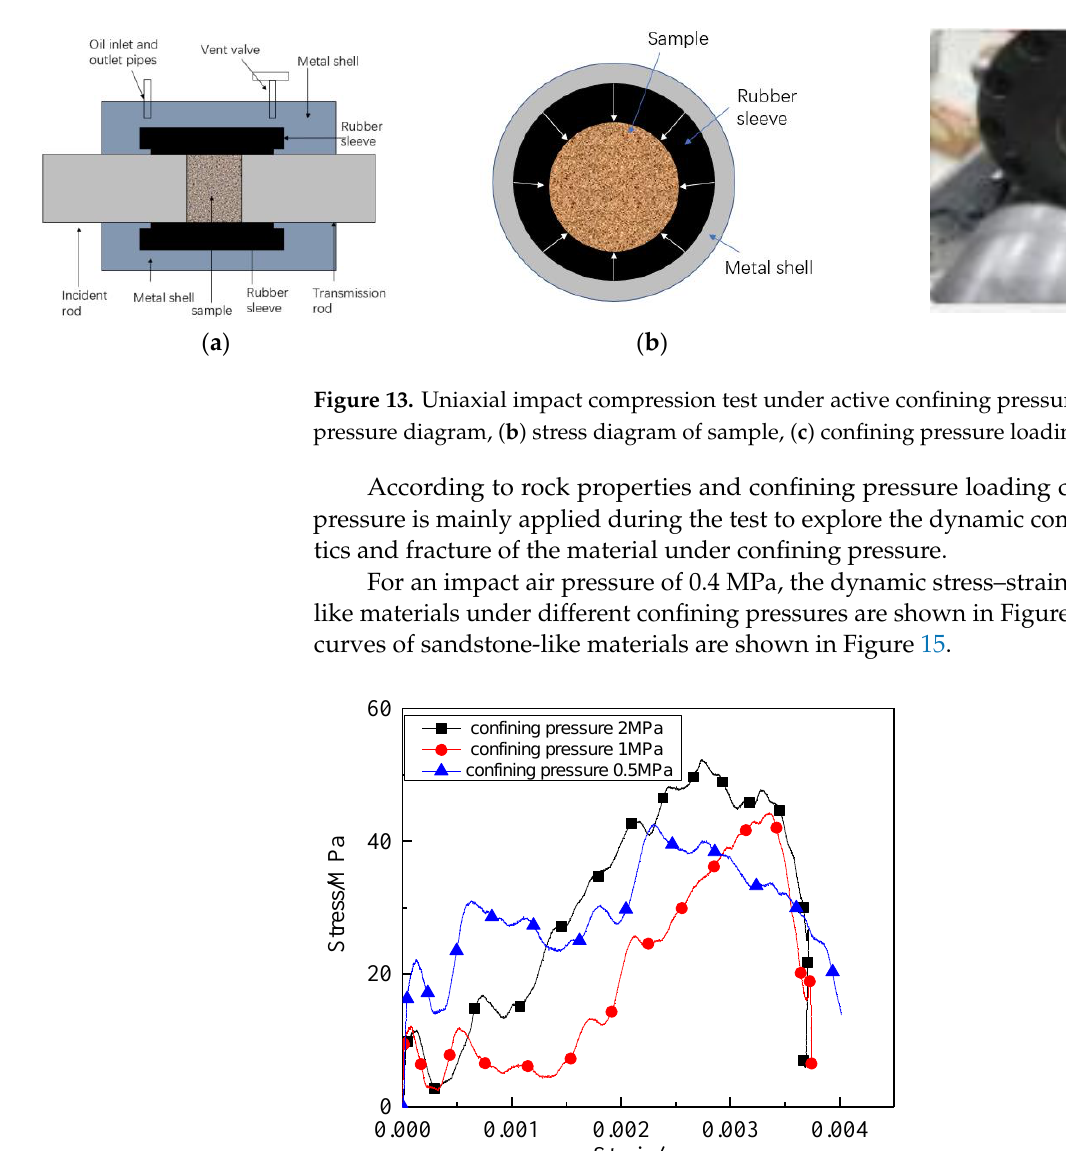
Figure 14. Dynamic stress–strain curve of mudstone-like material under active confining pressure.